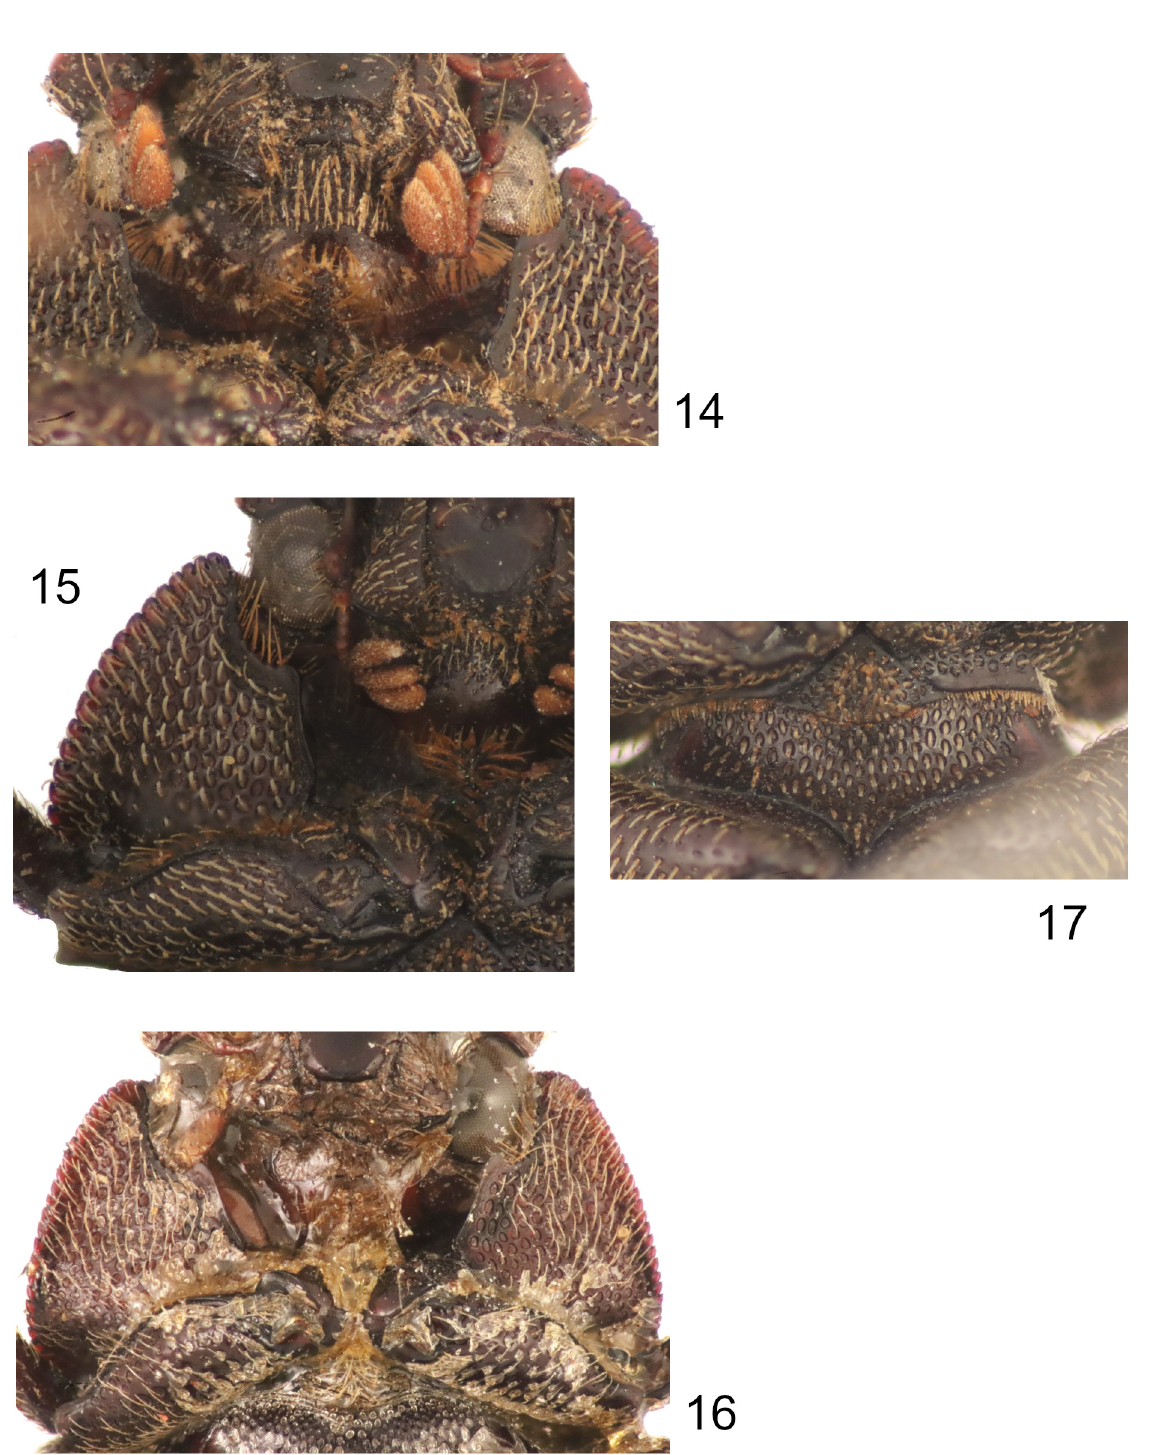
Figs 14–17. Maechidiini Burmeister, 1855 features. 14 . Maechidius corrosus Waterhouse, 1875, antennal pockets. 15 . M. major Blackburn, 1888, same. 16 . M. spurius Macleay, 1819, holotype, prosternum and pronotal hypomera, ventral view (BMNH). 17 . Same, mesoventrite. Not to